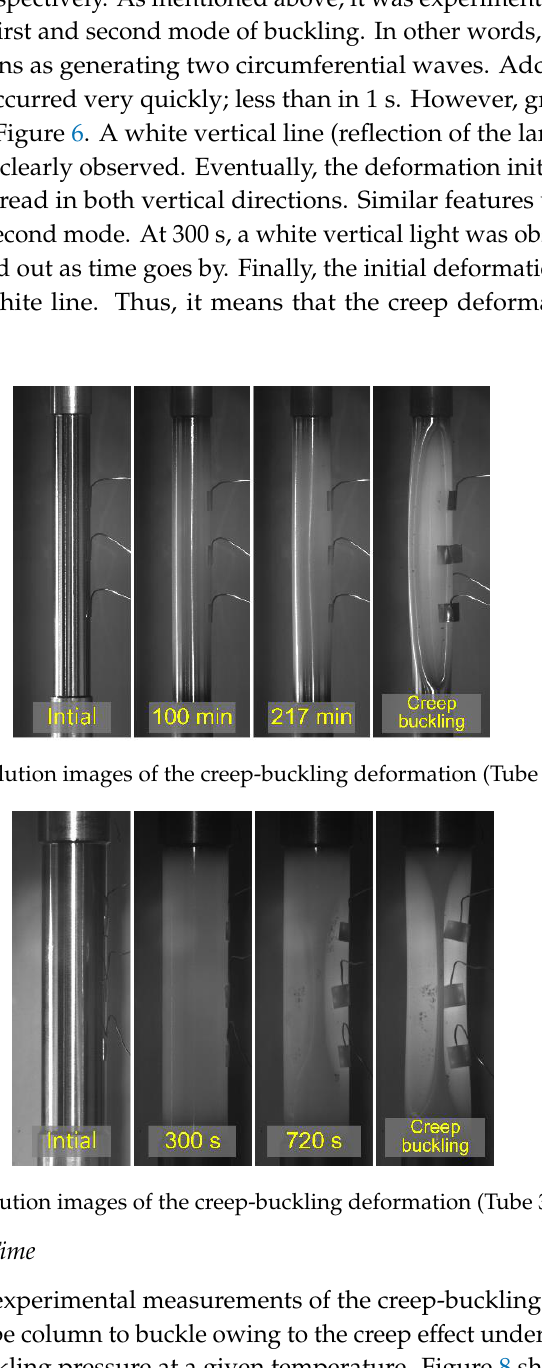
Figure 5. Comparison of the vertical temperature profiles of Tube 1-03 between the experimental measurements and numerical predictions.